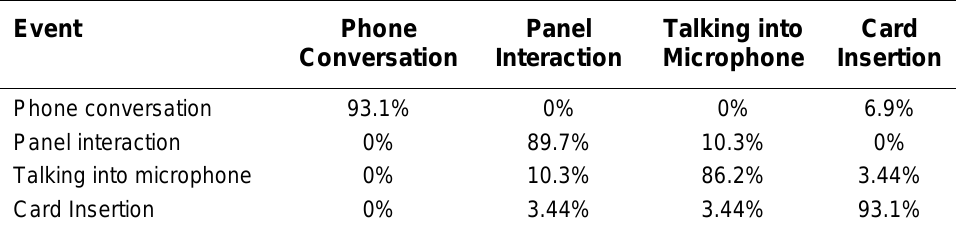
Event and Activity Detection